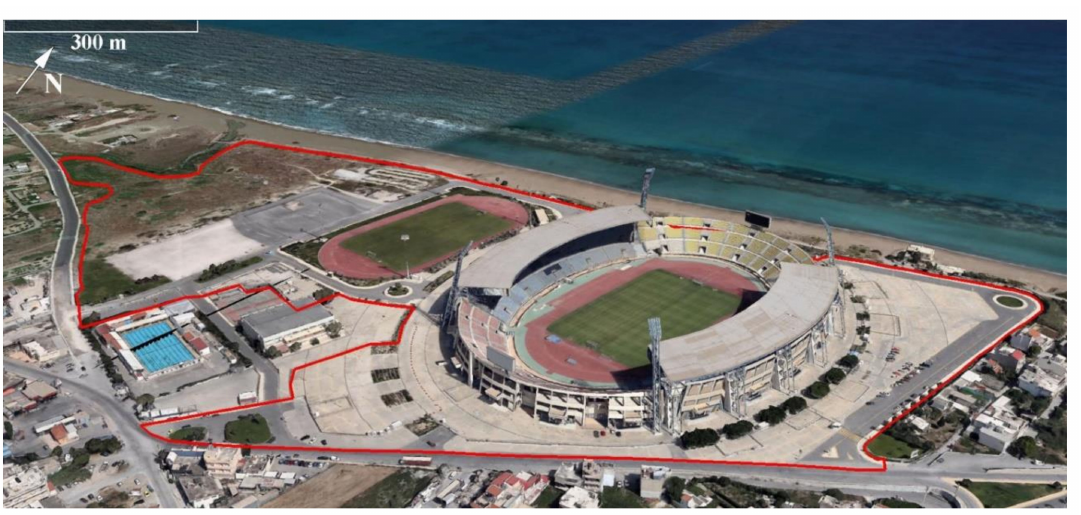
Figure 1. 3D representation of the Pancretan Stadium and the auxiliary outdoor space from